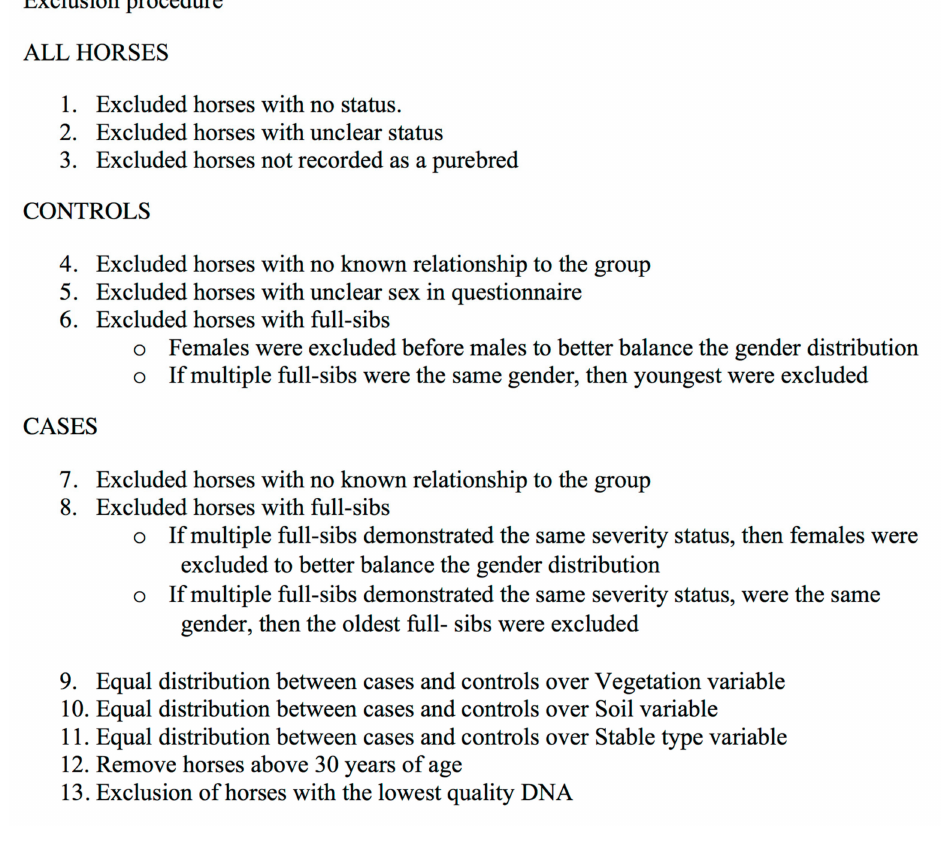
Figure A1. Exclusion protocol used to select Belgian Warmblood horses for